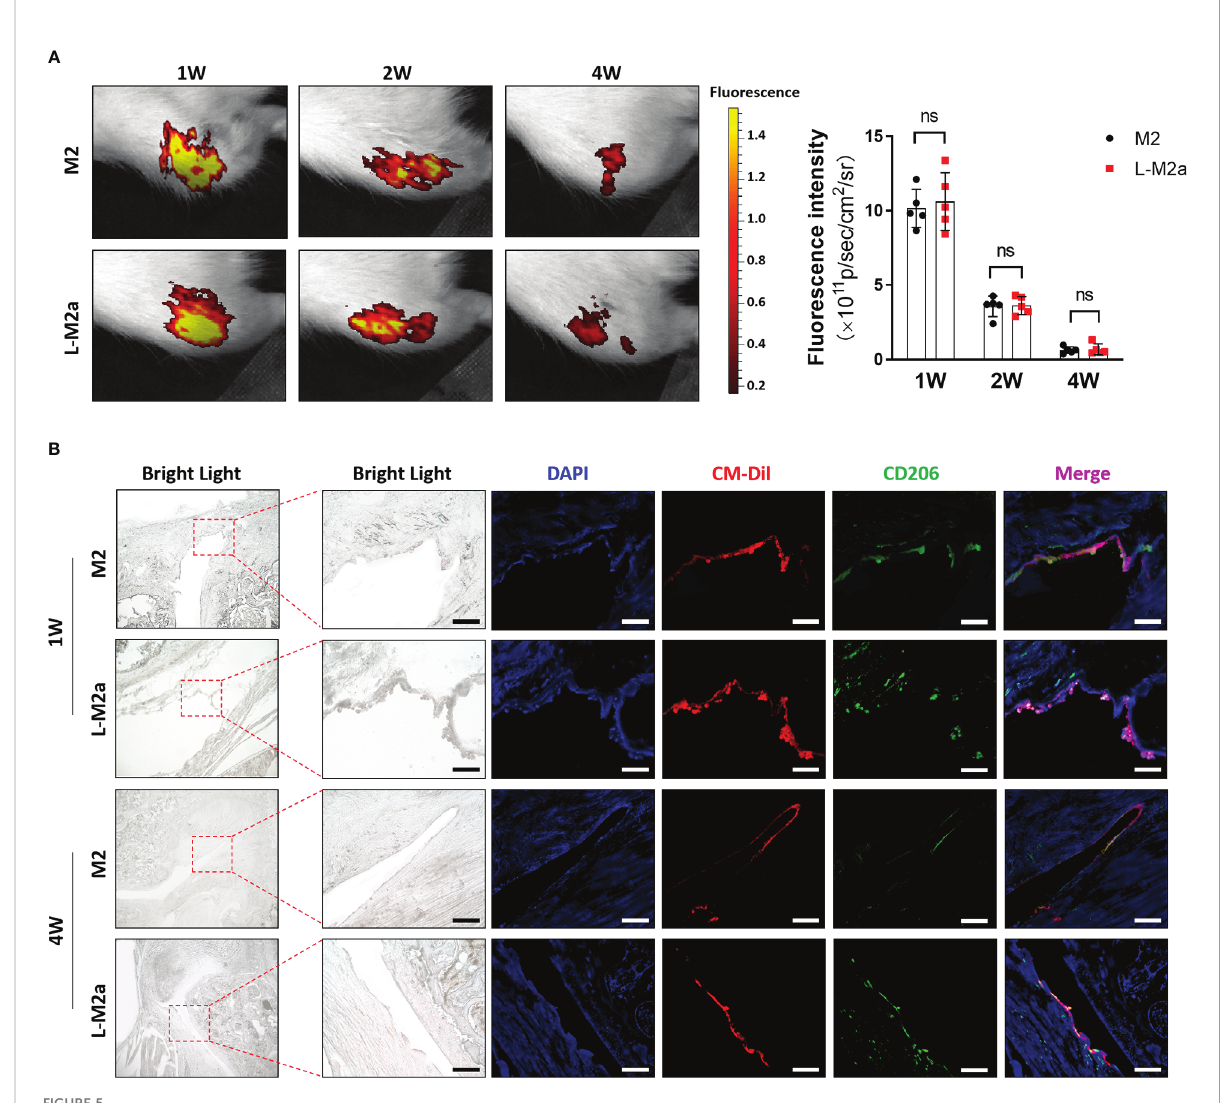
FIGURE 5 Tracing of L-M2a M j in vivo . (A) The fl uorescence intensity of CM-Dil labelled M2 or L-M2a M j at 1, 2, and 4 weeks after intra-articular injection by IVIS. (B) The bright light, DAPI staining (blue), CM-Dil labelled M2 or L-M2a M j (red), CD206 immuno fl uorescence (green) and merge vision of joints at 1 and 4 weeks after intra-articular injection. bar= 100 m m. ns, no signi fi cance; M j , macrophage; L-M2a M j , locked M2a